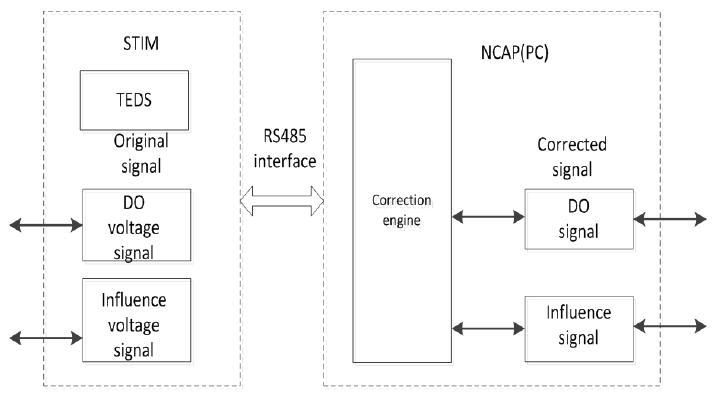
Figure 4. Model of data correction.